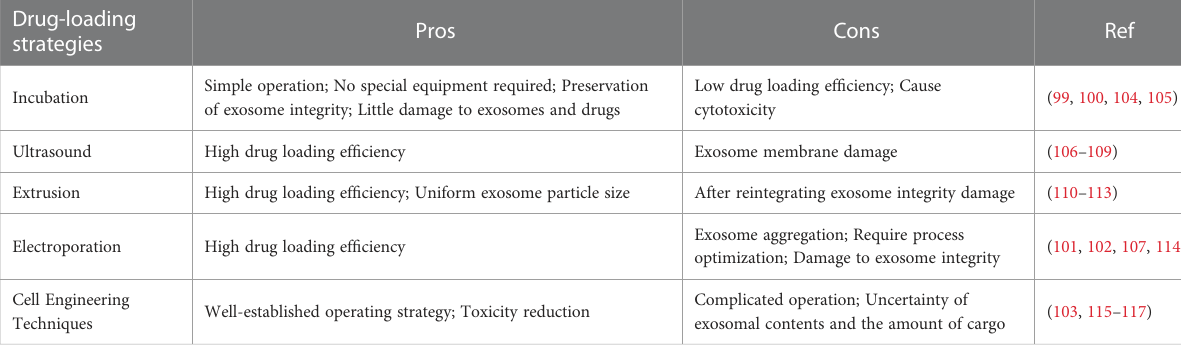
TABLE 1 The pros and cons of exosomes-based drug-loading strategies. Drug-loading